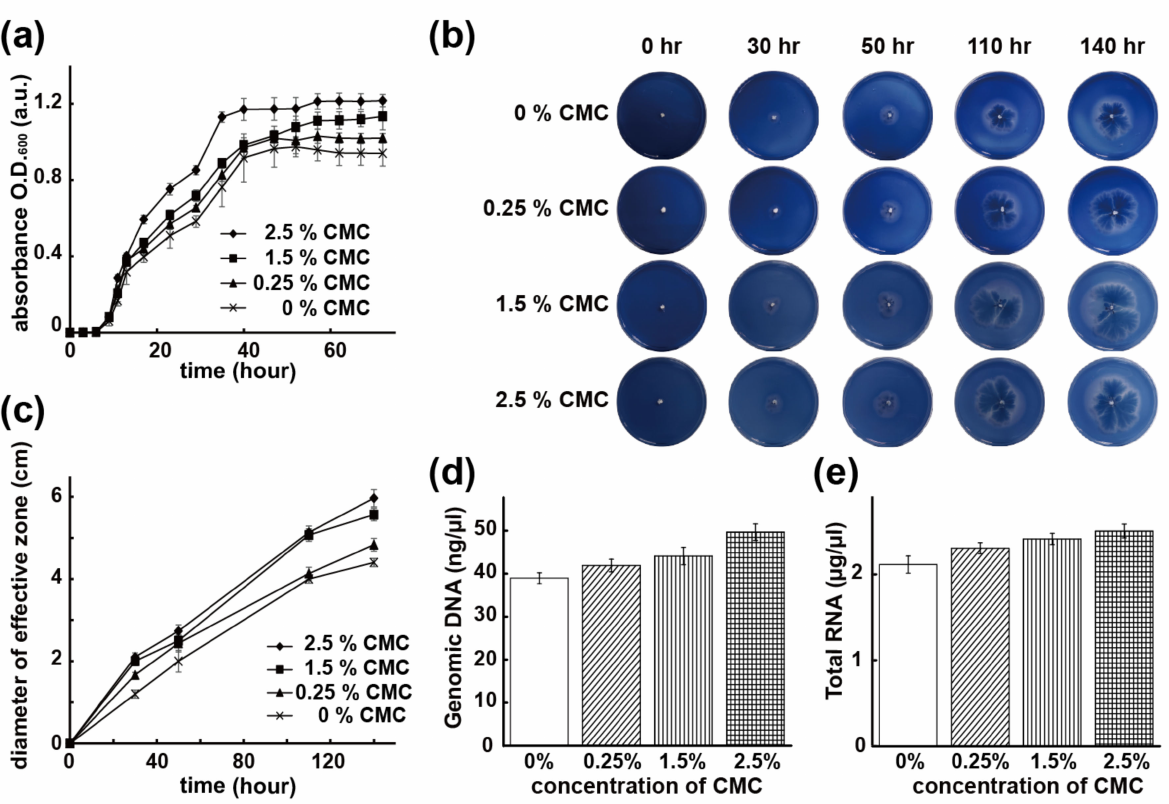
Figure 4. Regulation and quantification of bacterial biochemical activities of the bacterial capsules. ( a ) Regulation to enhance bacterial growth with respect to increasing CMC concentrations was verified in a studied culture time frame. ( b ) Regulated and enhanced enzyme activities of B. CMC1 were discovered with increasing CMC concentrations on agar plates for up to 140 h. ( c ) Quantification of the effective zones in panel ( b ) was compared. ( d ) Analysis of the genomic DNA for the studied groups confirmed the upregulated expression of the corresponding DNA according to the increments of CMC concentrations. ( e ) The same upregulated expression of total RNA unambiguously verified the proposed regulation mechanism by increasing CMC concentrations in the bacterial capsules. Statistical data were expressed as the mean value and the standard deviation based on three independent